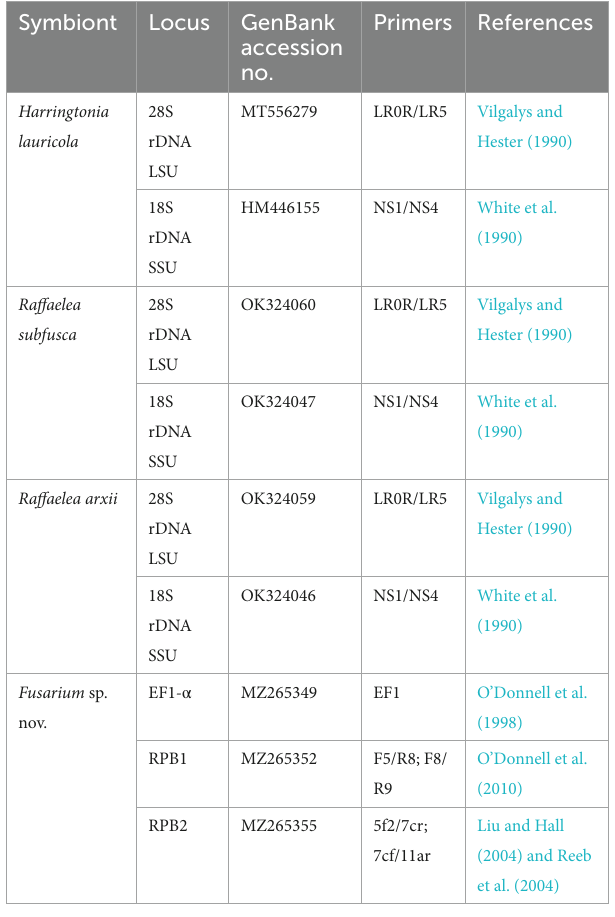
TABLE 1 GenBank accession numbers and primers used for identification of four fungal symbionts used as diets by Xyleborus bispinatus in this